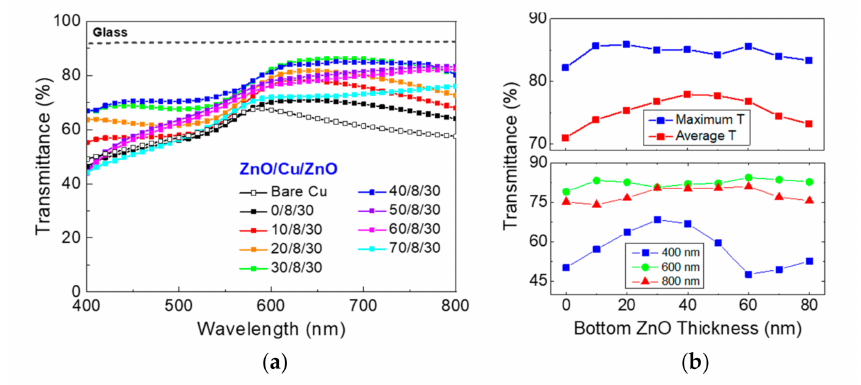
Figure 2. ( a ) Optical transmittance for the ZnO / Cu / ZnO electrodes as a function of incident beam wavelength. The thickness of top ZnO and Cu layers are fixed at 30 nm and 8 nm, respectively, while the bottom ZnO layer thicknesses were varied in the range of 0–70 nm. The transmittance of a bare Cu layer, i.e., having no top and bottom ZnO layers, is also included for comparison. The air baseline was taken and the transmittance of bare glass is also given as reference. ( b ) (upper panel) Maximum and average transmittance for the ZnO / Cu / ZnO electrodes are given as a function of bottom ZnO layer thickness. (lower panel) The transmittance evaluated at the wavelengths of 400, 600 and 800 nm are given, respectively, as a function of the bottom ZnO layer